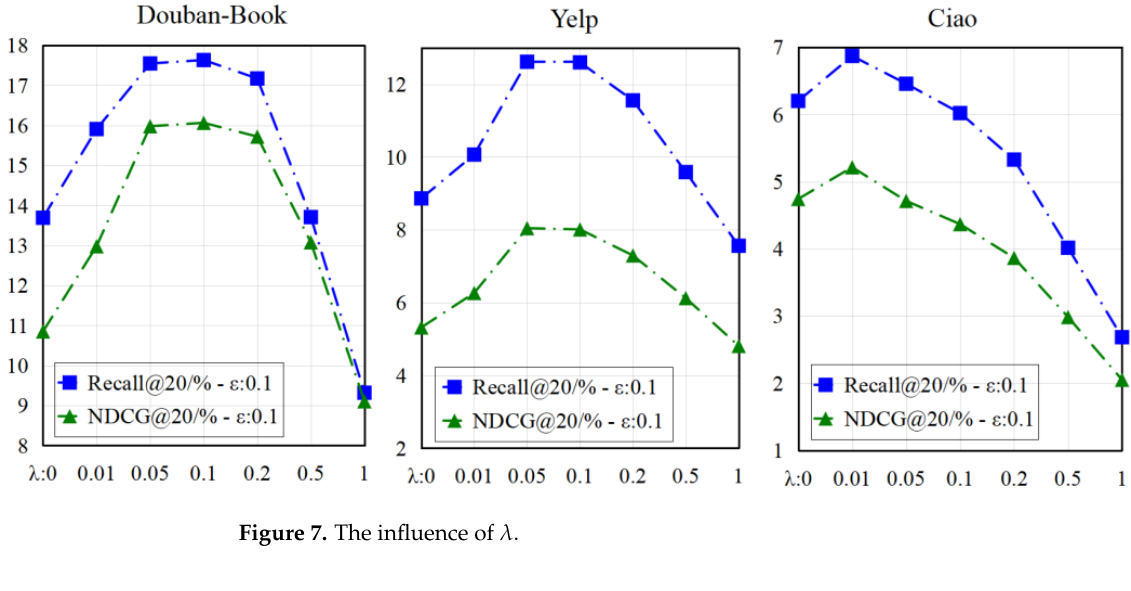
Figure 7. The influence of λ .